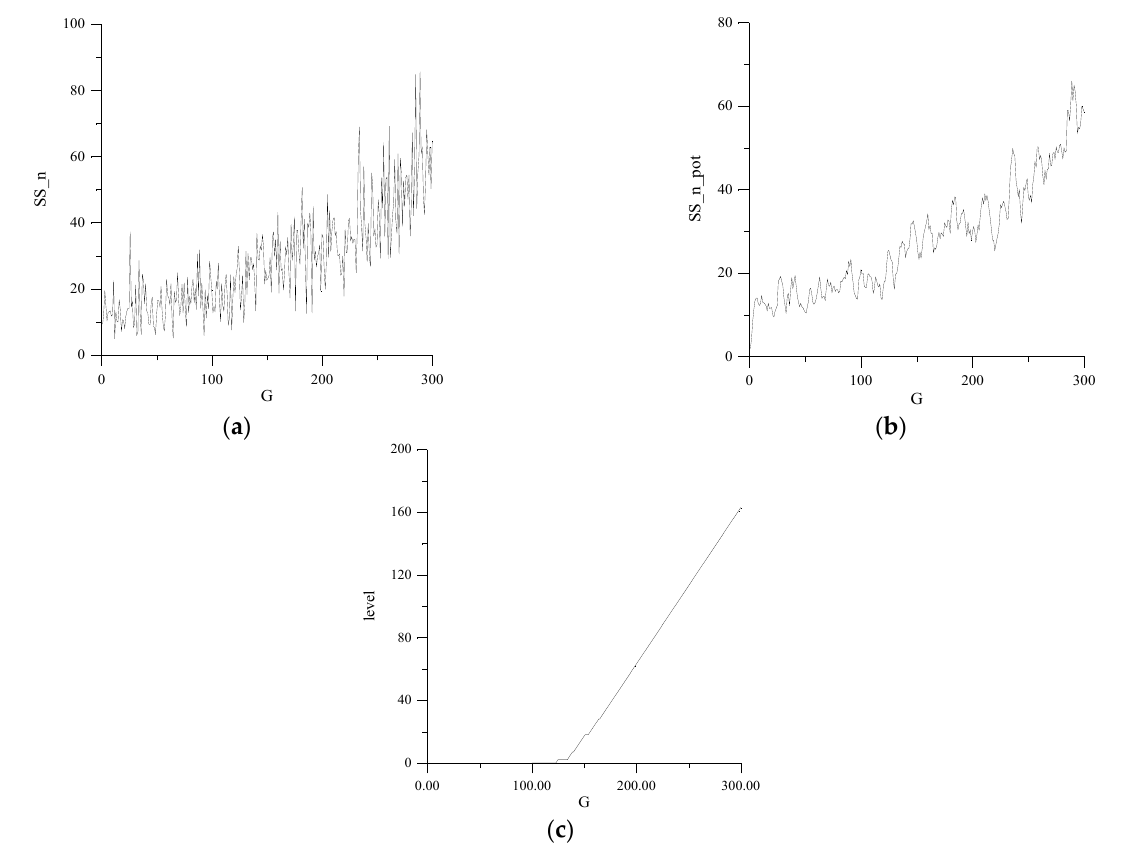
Figure 2. PPSG statistical characteristics based on MAFG ( q = 3 ) : ( a ) the value χ 2 c ; ( b ) the average value of the last five (current) values χ 2 c − χ 2 cav ; ( c ) number of values χ 2 cav greater than χ 2 cr . G—control code